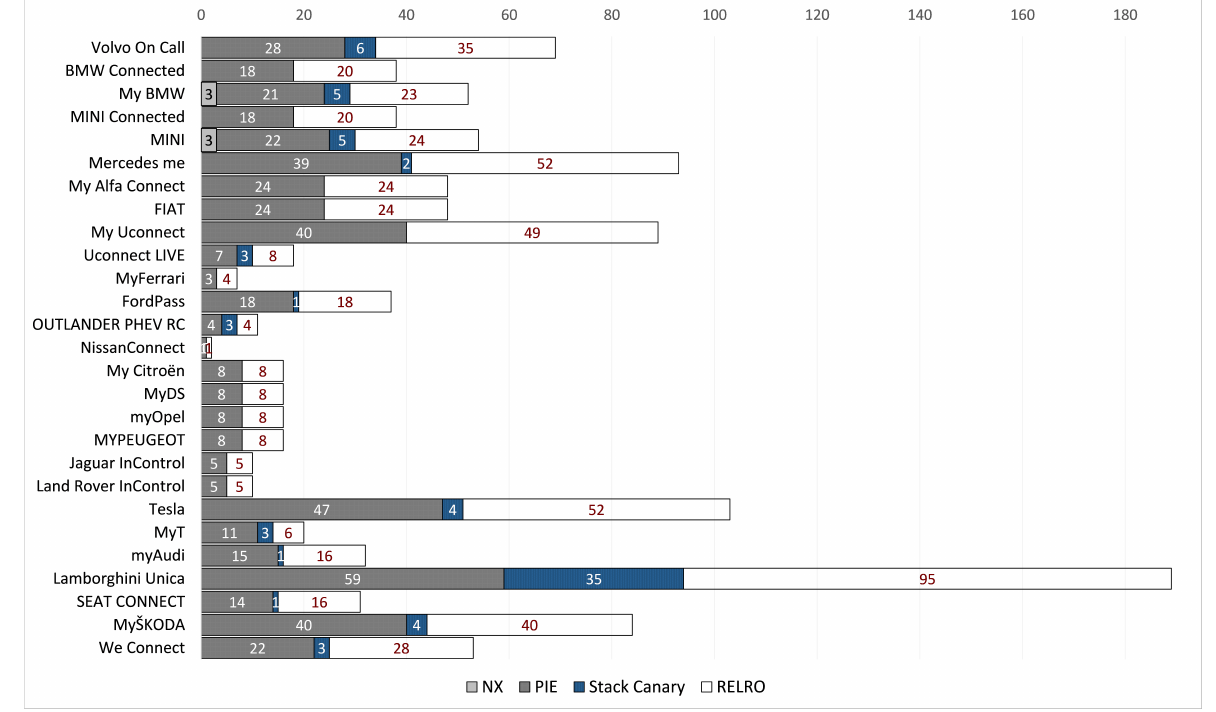
Figure 2. Number of vulnerable shared libraries per